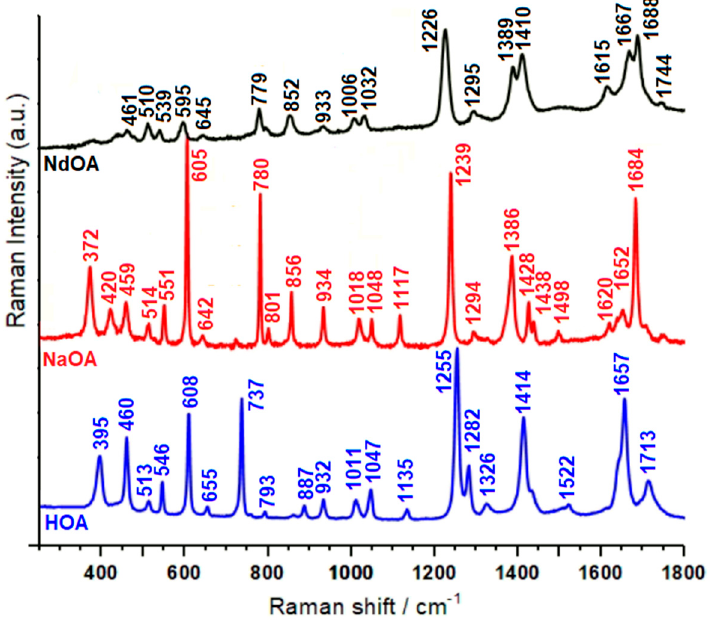
Figure 3. Raman spectra of the solid state of orotic acid (HOA), sodium salt of orotic acid (NaOA), and its Nd(III) complex. Excitation: 784.8 nm, 35 mW.